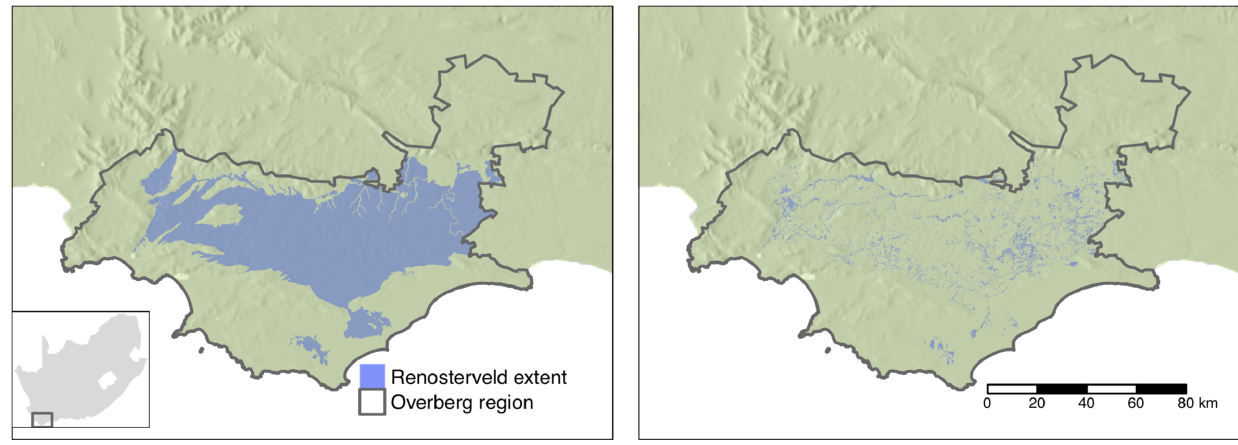
Figure 1. The Overberg district in South Africa. The left panel shows the natural extent of lowlands Renosterveld in the district and the right panel the remaining natural and degraded